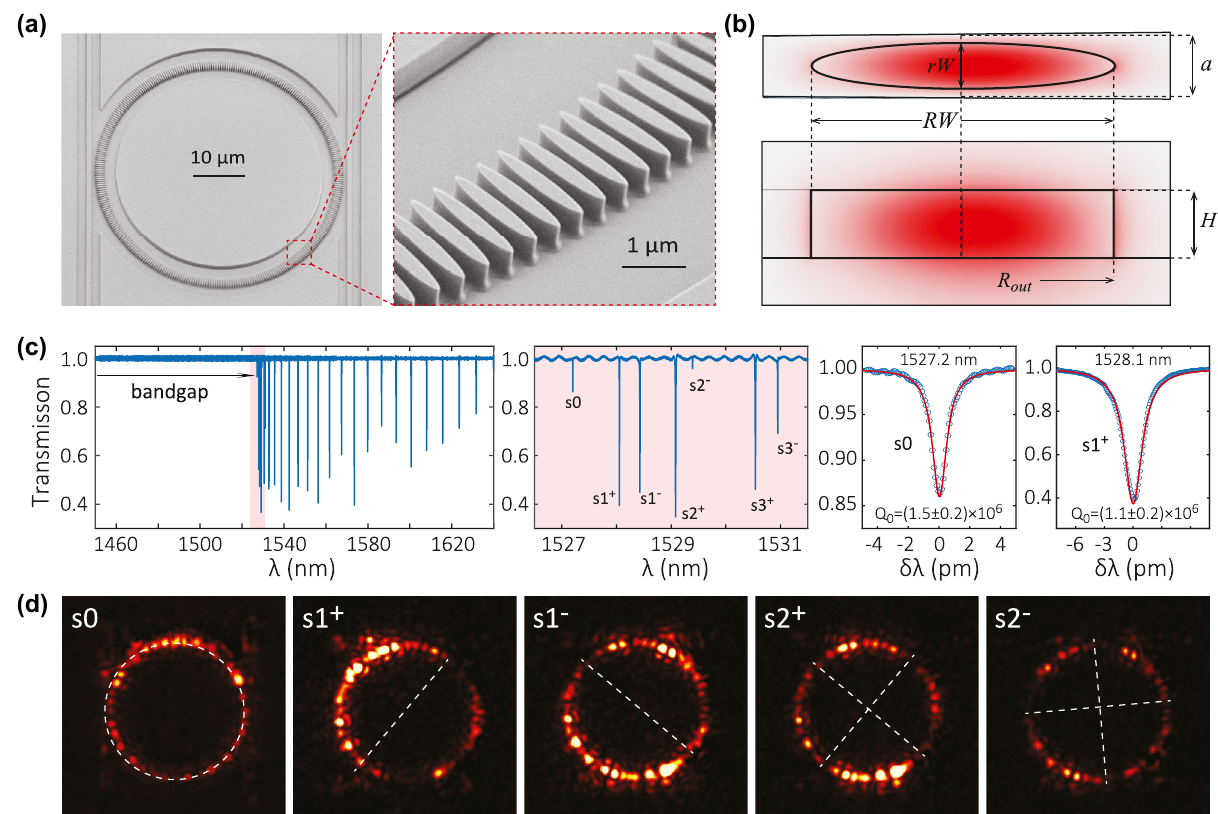
Figure 2: Introducing the rod photonic crystal ring (rPhCR). (a) SEM images of the rPhCR device and zoom-in view of several unit cells of the rod structure. The silicon nitride rods sit on top of a silicon dioxide substrate with top air cladding. (b) A finite-element-method simulation of a unit cell of the rPhCR device, showing the dominant (radial-direction) electric field profile in top and cross-section views. The cell is 1/324 of the rPhCR circumference, with a cell width of a = 460 nm and a thickness of H = 500 nm. The elliptical rod has a major axis length of RW = 2.25 μ m and minor = 24.875 μ m. The simulated resonance frequency for the dielectric band-edge mode ( s 0) axis length of rW = 354 nm, and its outer ring radius is R out